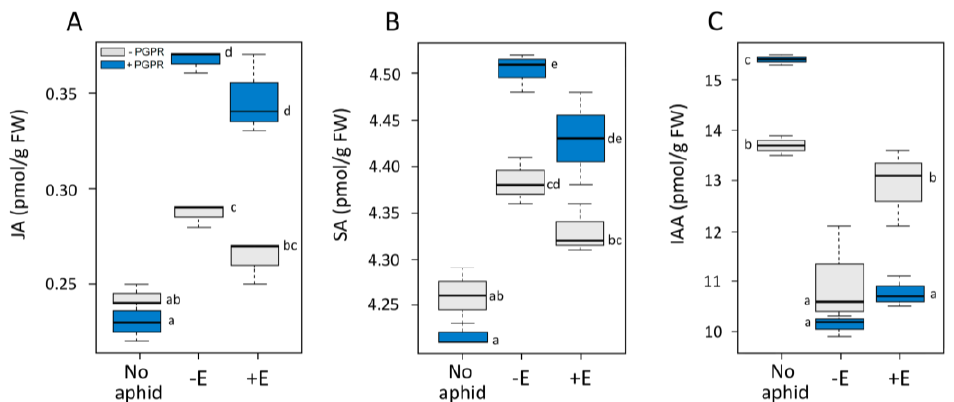
Figure 2. Boxplots of phytohormone levels (jasmonic acid (JA), salicylic acid (SA), and indole-acetic acid (IAA)) in plants inoculated or not inoculated with B. amyloliquefaciens ( + PGPR and − PGPR, respectively) and infested or not infested by A. pisum aphids − E and + E (absence and presence of endosymbiont H. defensa , respectively). The di ff erent letters indicate significant di ff erences between groups (Tukey’s HSD, p < 0.05, n =